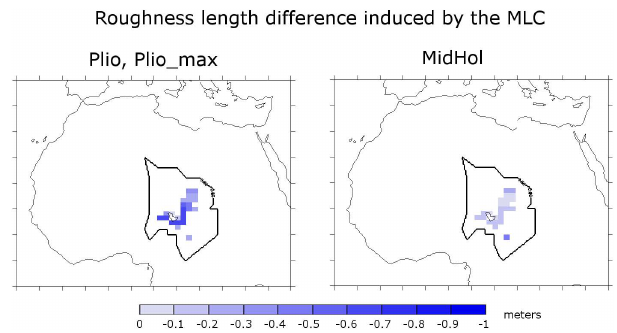
Fig. 8. Roughness length (m) difference between “lake” and standard experiments.The differences between mid-Holocene and Pliocene are due to different lake free vegetation